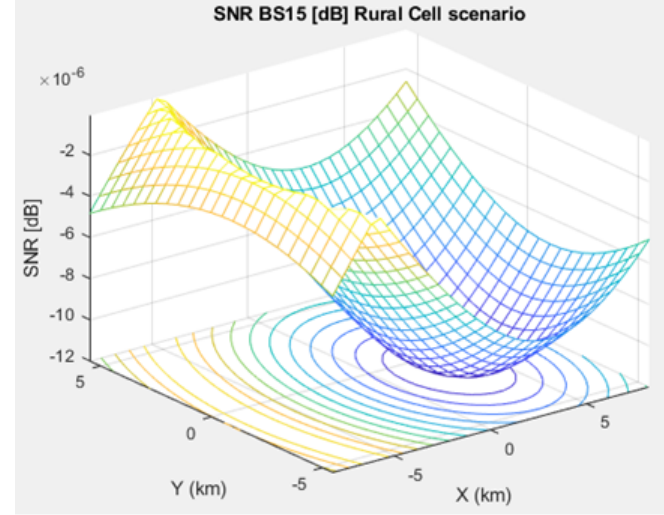
Figure 10. SNR for BS No. 15 in a rural macrocell scenario.